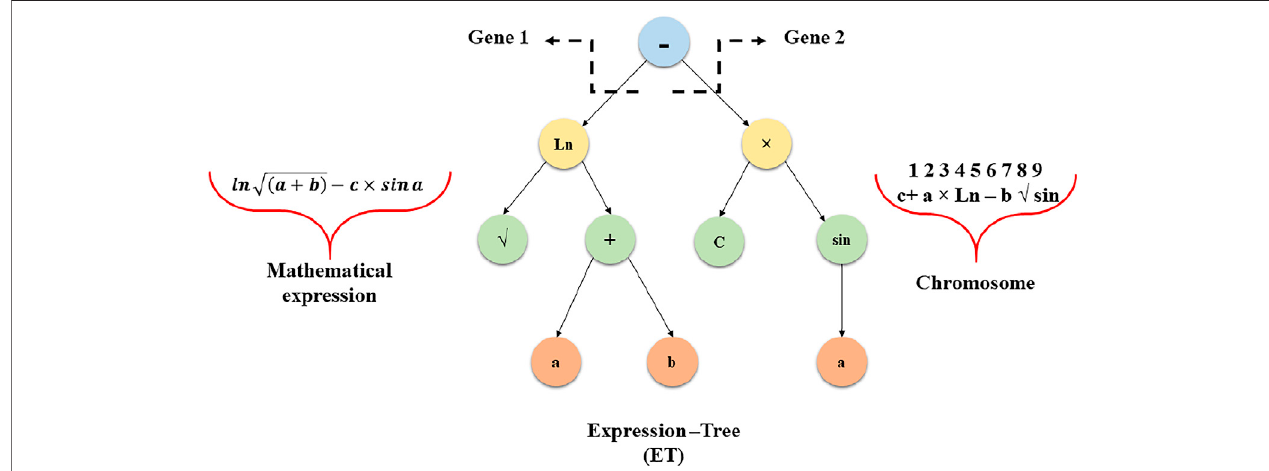
FIGURE 3 | Typical representation of linear string and their GEP model.